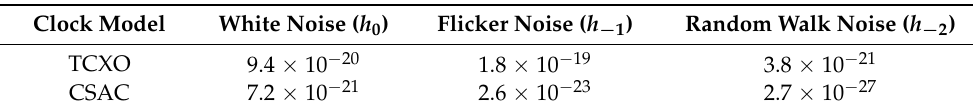
Table 1. Theoretical clock error modelling, TCXO and